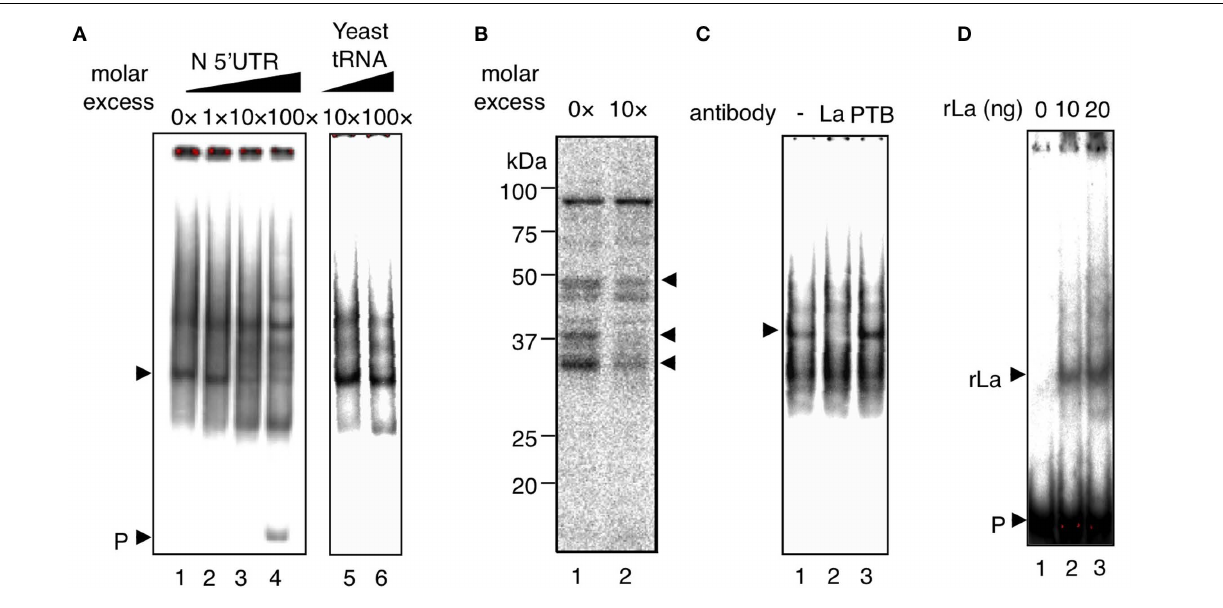
FIGURE 2 | Laspecifically interacts with N-5 (cid:2) UTR. (A) EMSA was performed with the N-5 (cid:2) UTR probe (P) and B95a cell extract. A specific competitor was added at the indicated molar excess ratio (lanes 2–4).Yeast tRNA was added at the indicated molar excess ratio as a non-specific competitor (lanes 5 and 6).The specific complex is indicated by an arrow. (B) The UV cross-link assay revealed that the molecular weight of specific-binding protein (which disappeared with the addition of a specific